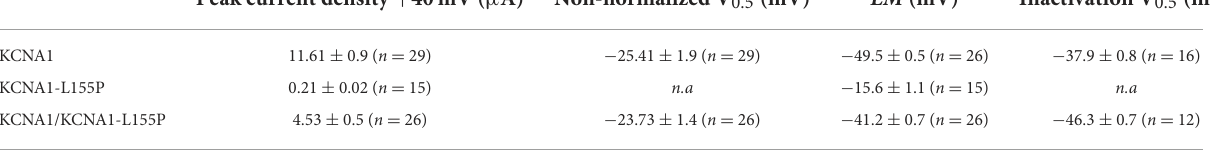
TABLE 1 Cellular electrophysiological characteristics of wild-type (WT) KCNA1, and homozygous and heterozygous KCNA1-L155P potassium